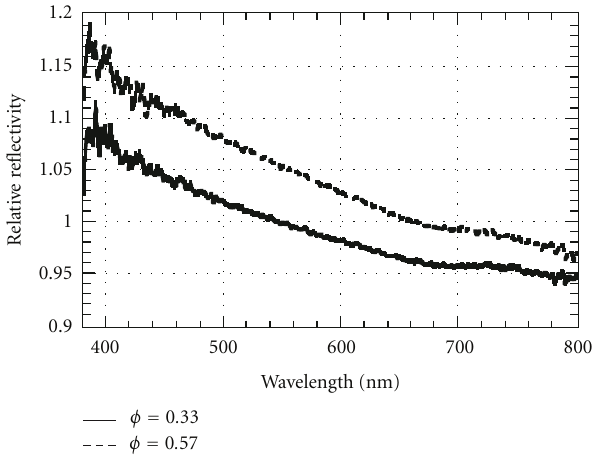
Figure 3: Typical relative reflection spectra of TiO 2 NW-coated glass slide with surface coverage fraction of φ = 0.33 (solid line) and φ = 0.57 (broken line). The refractivity of 1.0 indicates the reflection of the glass slide without the NW